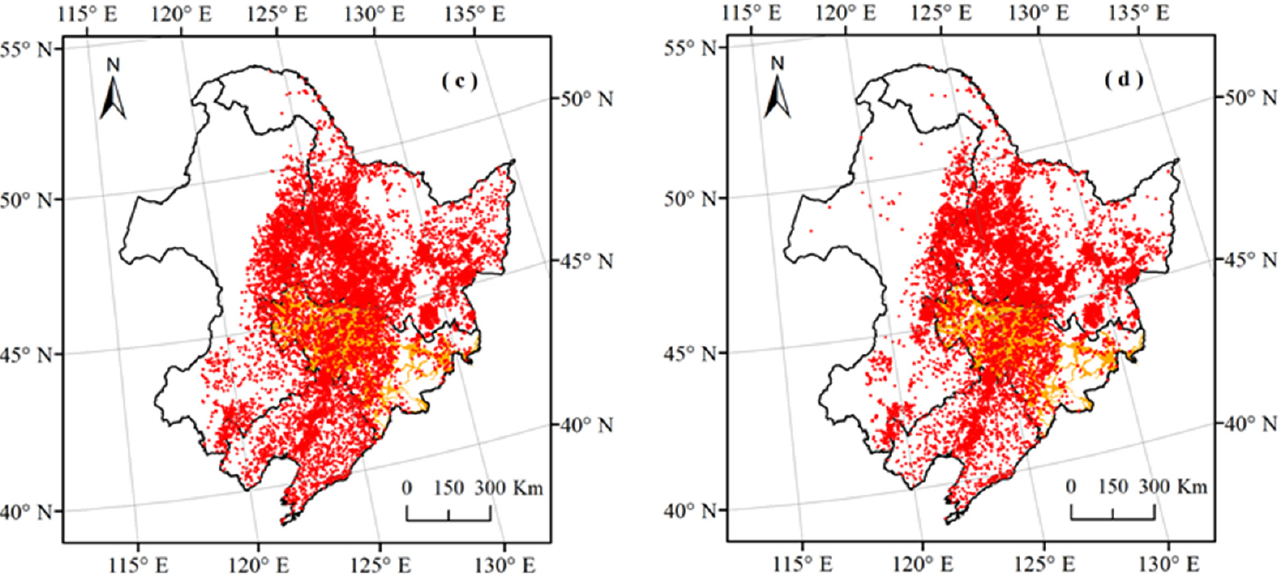
Figure 3. Spatial distribution of observation and verification field burnings in Northeastern China compared from 16 March to 20 April in 2021; ( a ) shows observed data by the Himawari-8 satellite (blue points); ( b – d ) present verified data produced by LR, BPNN and DT methods, respectively (red points), as noted by the inset abbreviations. Orange shading represents the straw open burning prohibition areas within Jilin Province.